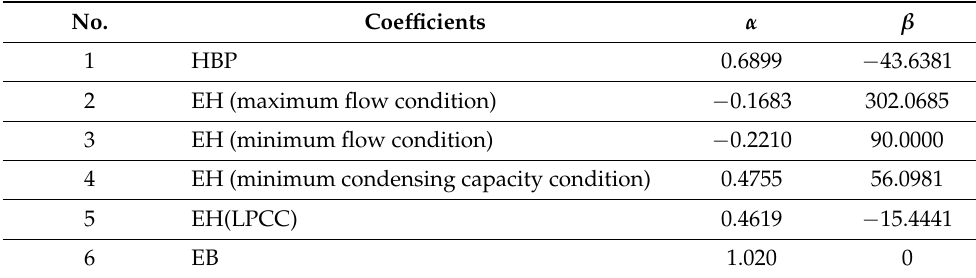
Table 1. Coefficients of unit electrical and thermal characteristics equation.